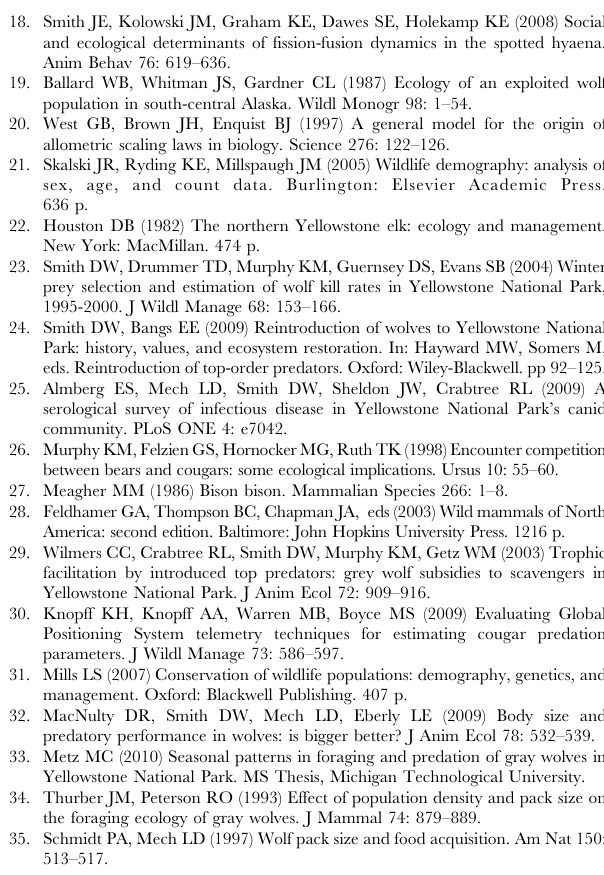
Figure S1 Linear models of pup survival for the seven packs for which summer prey acquisition rates were estimated. The y-axis displays high counts of pups observed throughout the summer monitoring period, beginning 1 May. Each panel (A-G) displays the equations from which pup survival was determined, with dates for which each equation was used in parentheses. Note the different x - and y -axis scales. The table located in the top-right of Fig. S1 displays the number of pups born and the predicted number of pups surviving for each pack on 15 May, 15 June, and 15 July. Figure S2 Proportion of detected carcasses for which the number of individual wolf locations within the 100 m carcass buffer no longer increased following the time period. For small ungulates ( n = 174), . 85% of carcasses are no longer active after 1 day while . 85% of large ungulate carcasses ( n =183) are no longer active after 3 days. Figure S3 Frequency of observations for the number of individual wolf locations within 100 m of a carcass for large ( n = 183) and small ( n = 174) ungulates during the allowed time